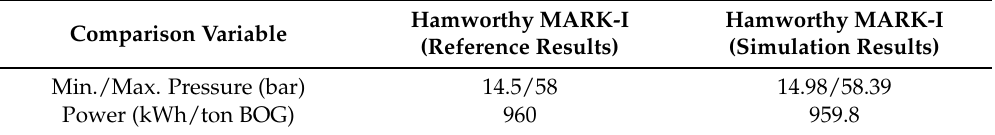
Table 3. Comparison of the reference and simulation data for the MARK-I from Hamworthy in terms of pressure range and